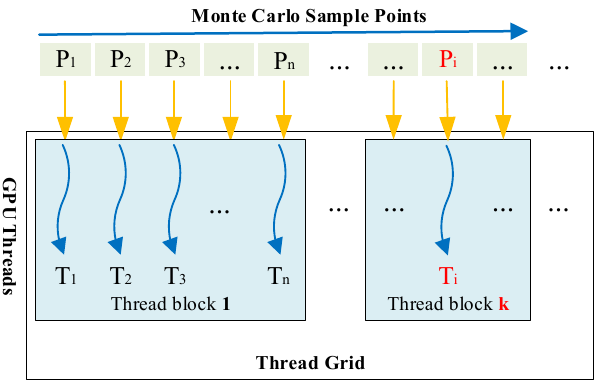
Figure 5. Thread hierarchy designed for GPU-based MCHVI indicator.